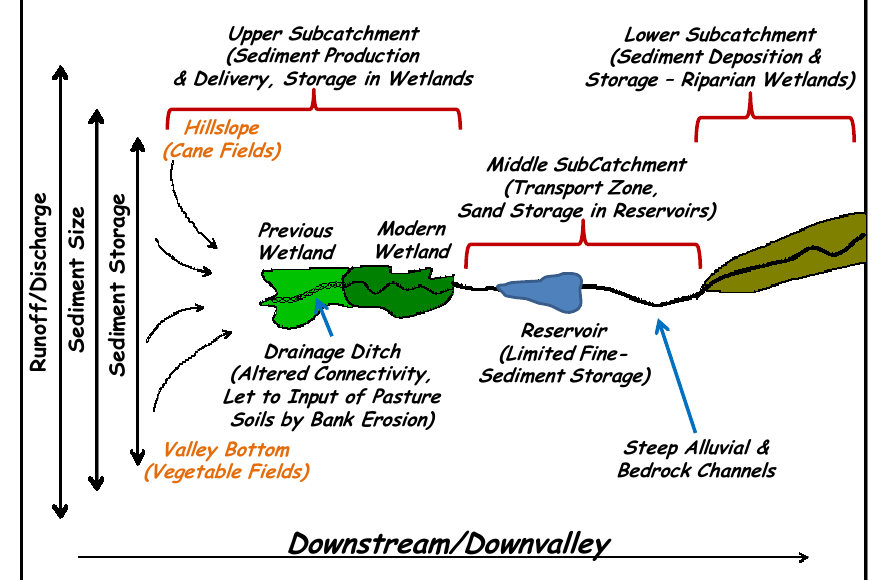
Fig. 13. Schematic diagram of the primary processes occurring in each of the three delineated subcatchments, and the variations in sediment size and source from varying runoff magnitudes.